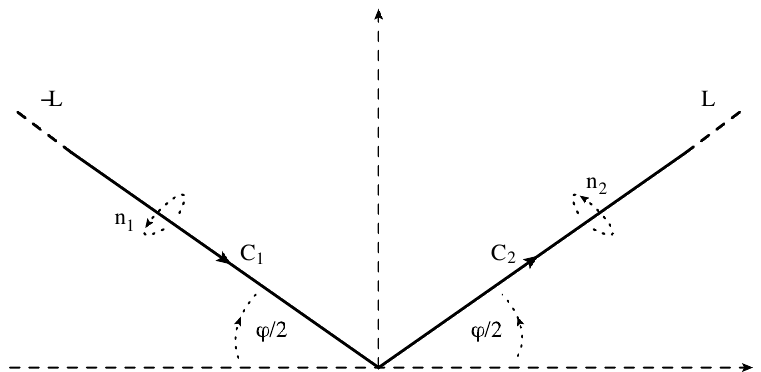
Figure 1 . The planar Euclidean cusp with angular opening (cid:25) (cid:0) ’ between the Wilson